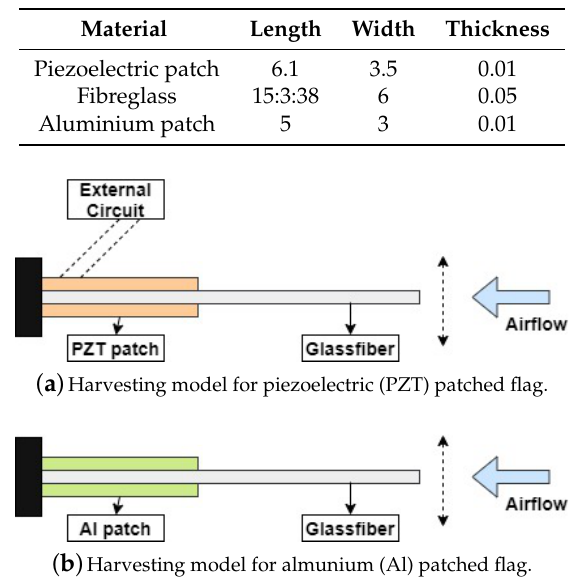
Table 2. Dimensions of flag in numerical campaign (cm).